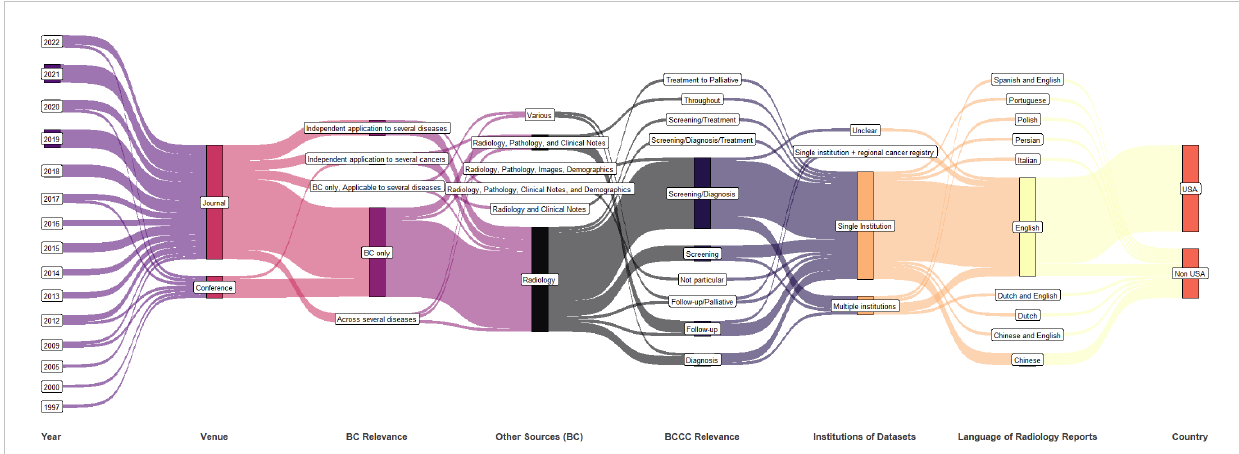
FIGURE 3 Synthetic analysis (Sankey plot) showing the relationship among publication year, venue, diseases studied, data type, number of institutions in the dataset, radiology report language, and